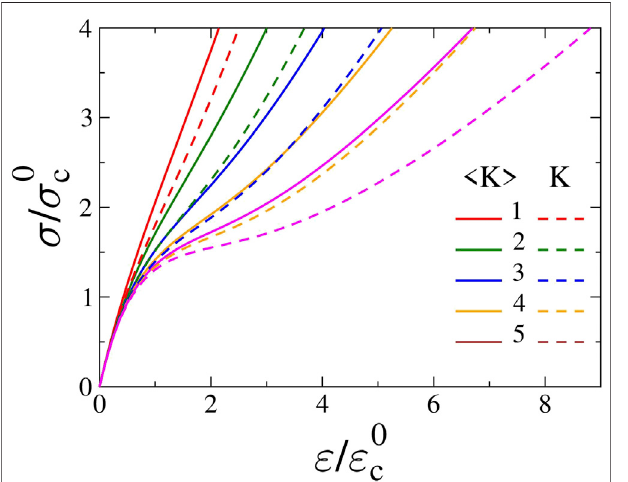
FIGURE 7 | Comparison of the constitutive curves of stick-slip bundles with constant ( dashed lines ) and fl uctuating ( continuous lines ) maximum number of slip events for the case of softening at the stiffness parameter a (cid:1) 0 . 8. The constant K values are set to be equal to the average 〈 K 〉 of the Poissonian